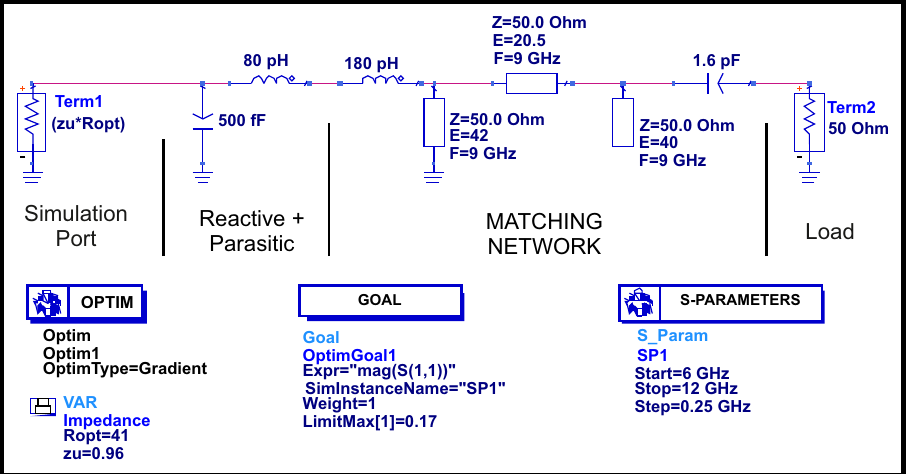
Figure 6. Linear simulator for the optimization of the matching network targeting the 0.5dB output power contours.